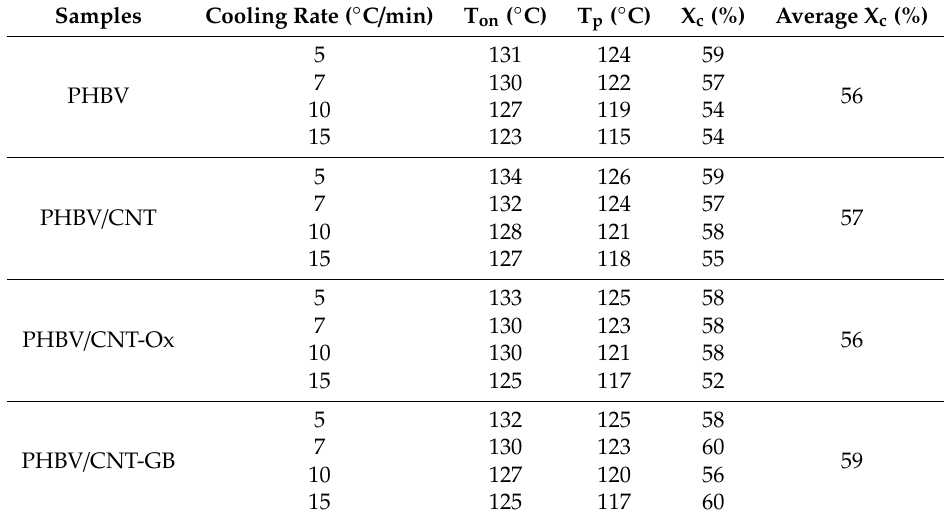
Table 2. Summarized DSC results at various cooling rates (5, 7, 10, and 15 ◦ C / min) for PHBV, PHBV / CNT, PHBV / CNT-Ox, and PHBV /